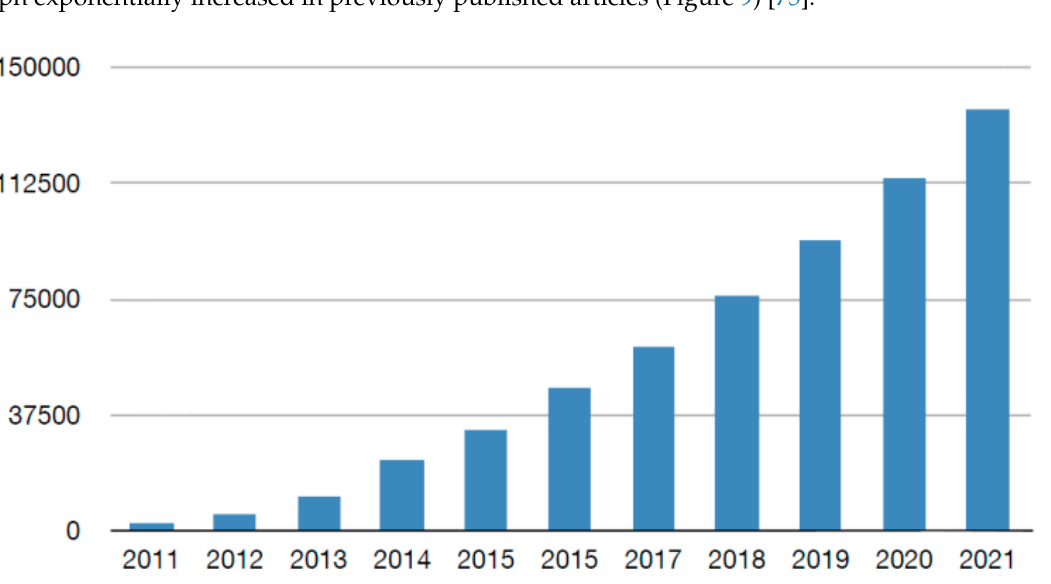
Figure 9. Global market trends for nanotechnology in drug delivery 2011–2021. Adopted from “Market Opportunities in Nanotechnology Drug Delivery”. Available at: http://www.cientifica.com/market-opportunities-in-nanotechnology-drug-delivery/. Last accessed 9 May 2019.